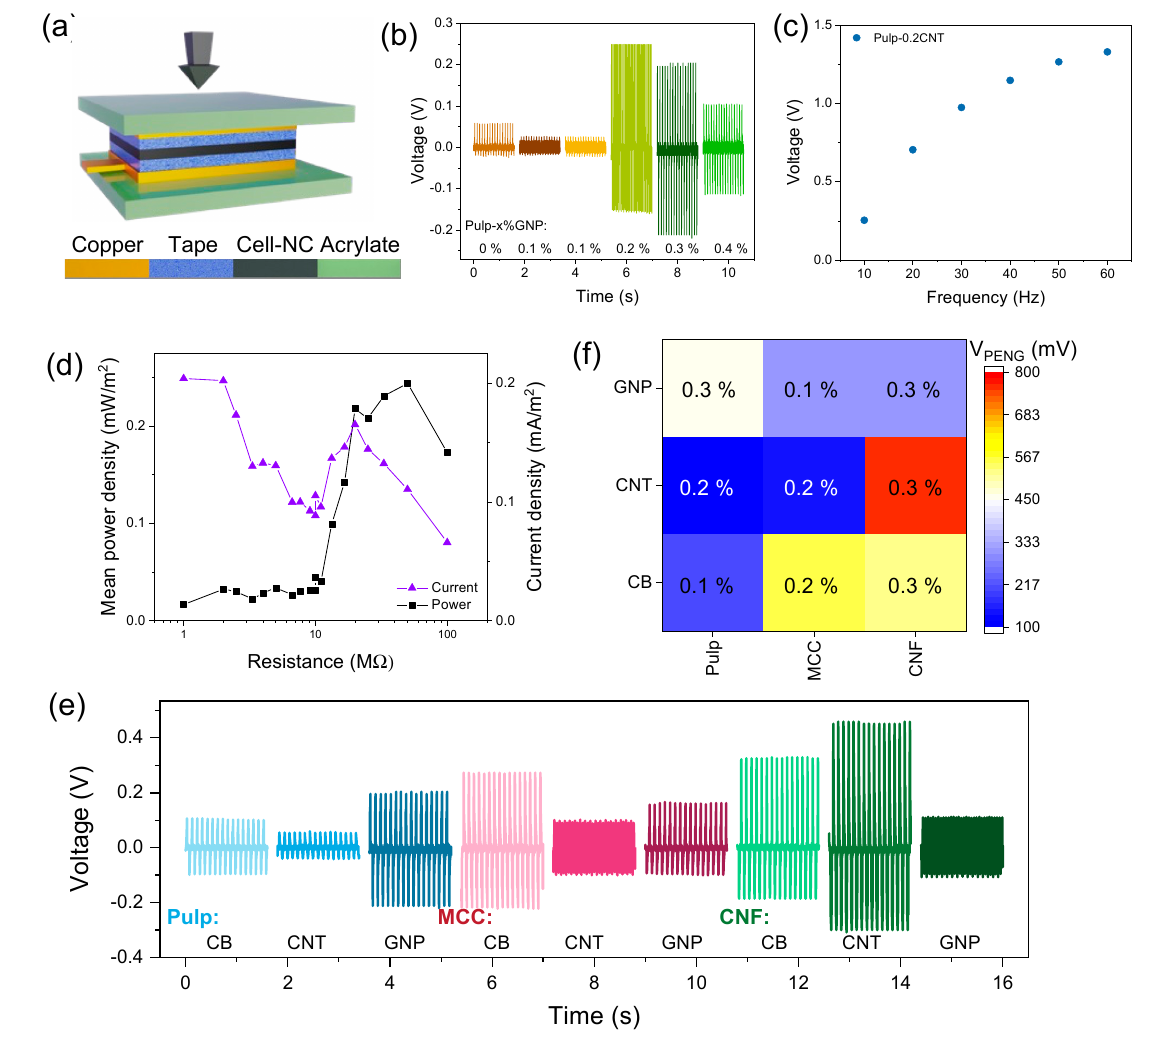
Figure 6. Piezoelectric harvesting measurements. Illustration of a PENG in tapping mode with the nanocomposite film between current collectors ( a ). Piezoelectric output voltage of pulp as a function of the GNP filler content ( b ). Voltage as a function of the tapping frequency of pulp-0.2%CNT ( c ). Current density and mean power density curves of pulp-0.3%GNP ( d ). Piezoelectric output voltage of all cellulose–nanocarbon combinations ( e ). Heat map of the maximum piezoelectric output voltage at the optimum nanocarbon content of each cellulose–nanocarbon combination ( f